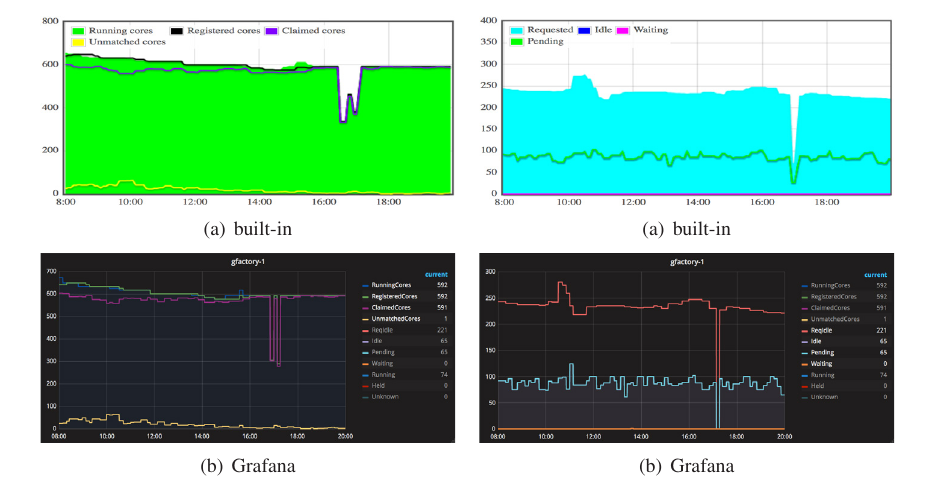
Figure 1. Comparison of running pilots at a particular compute element from built-in GlideinWMS vs new Grafana monitoring